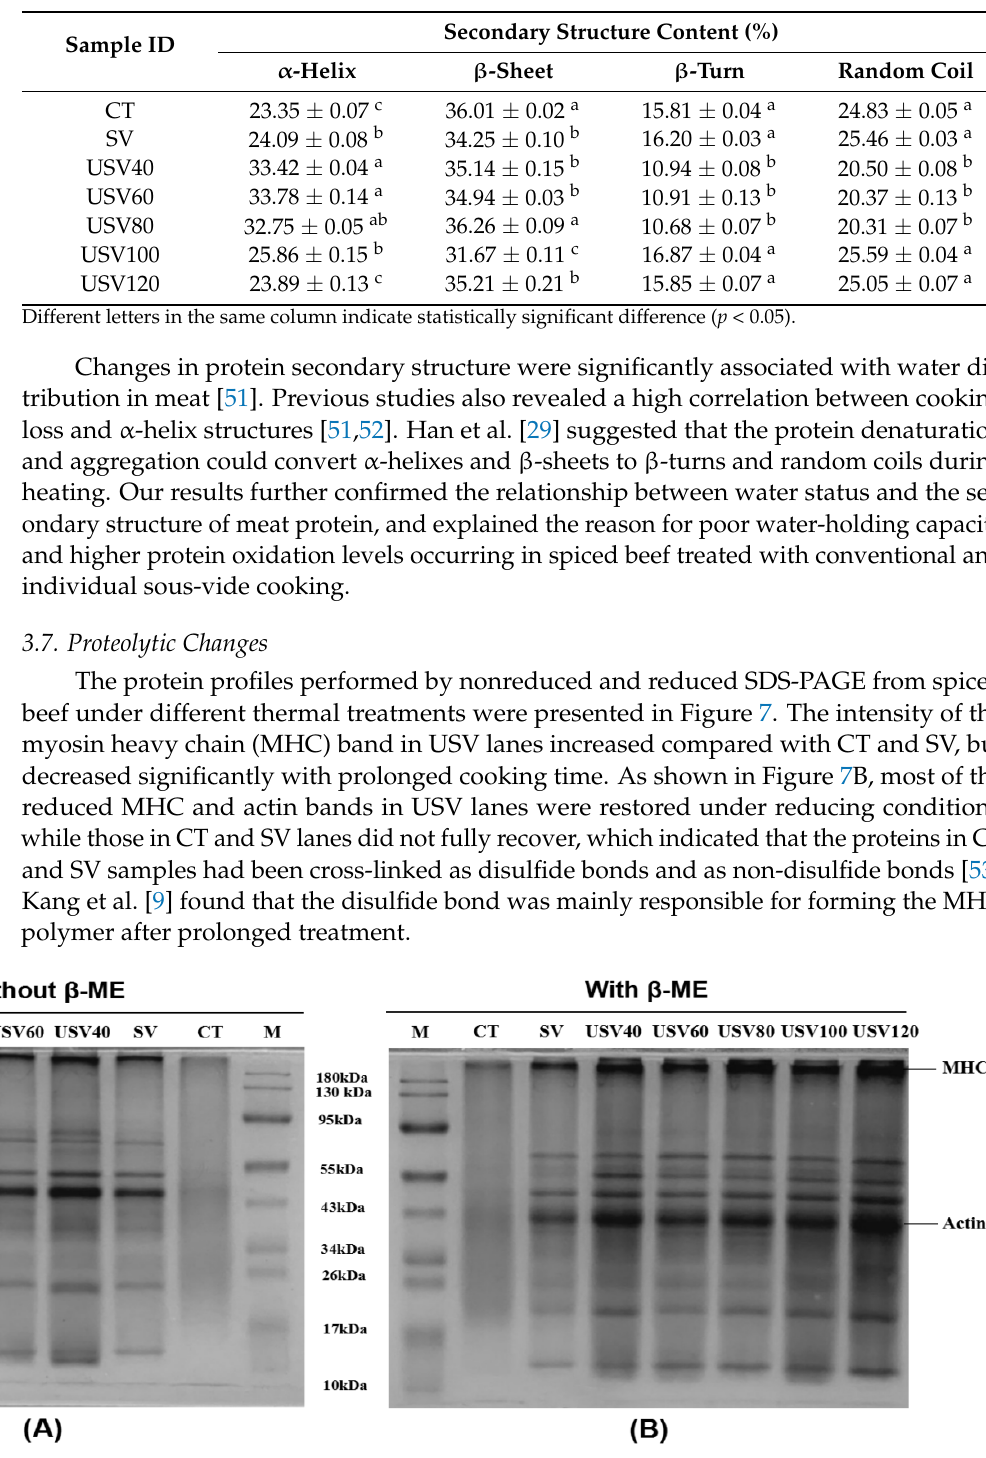
Figure 7. SDS-PAGE profiles of proteins in spiced beef under different thermal treatments. Samples were prepared without ( A ) and with ( B ) β -mercaptoethanol ( β -ME) addition. M: protein